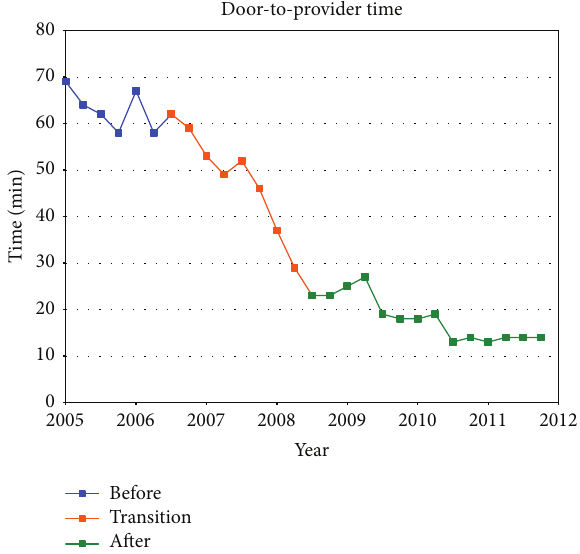
Figure 5: Median quarterly door-to-provider time: the median time patients spent waiting before being seen by a provider.